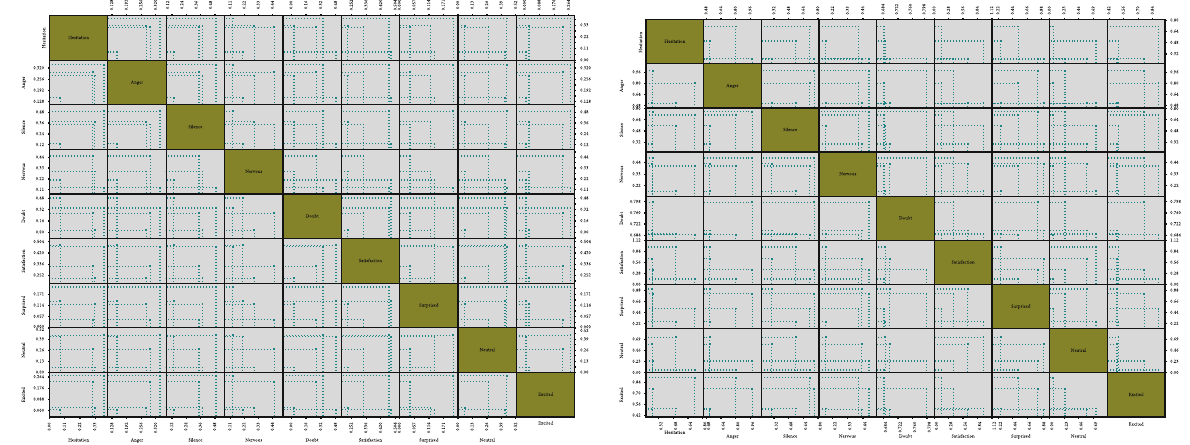
Figure 6: Comparison of scores of Xlnet-l12 and TRE classroom emotion recognition